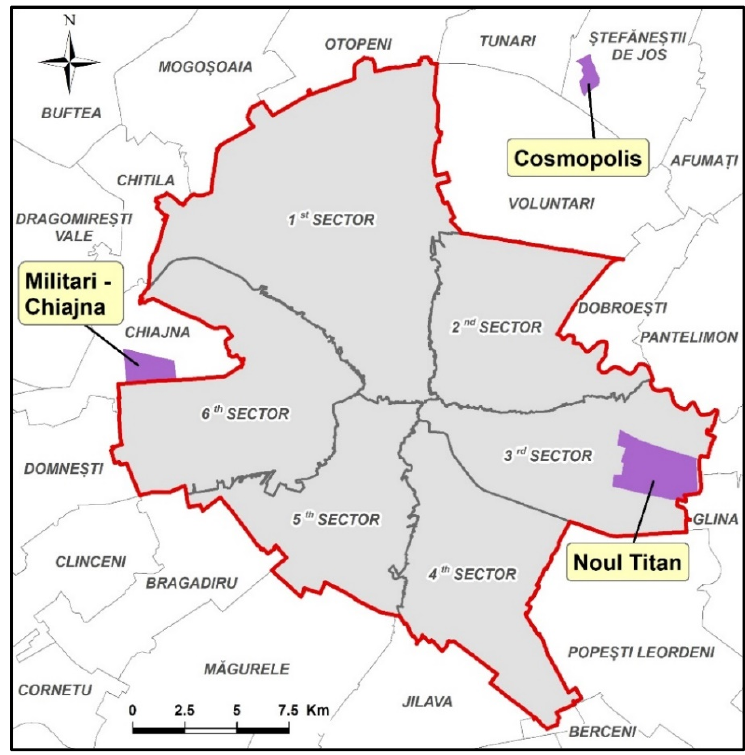
Figure 3. Position of the sample new residential areas in relation to Bucharest.